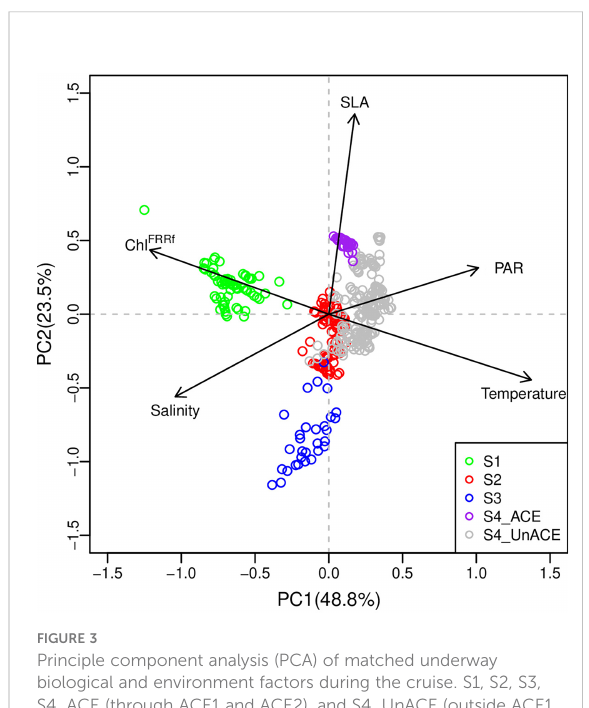
FIGURE 3 Principle component analysis (PCA) of matched underway biological and environment factors during the cruise. S1, S2, S3, S4_ACE (through ACE1 and ACE2), and S4_UnACE (outside ACE1 and ACE2) were dots in green, red, blue, purple, and gray,